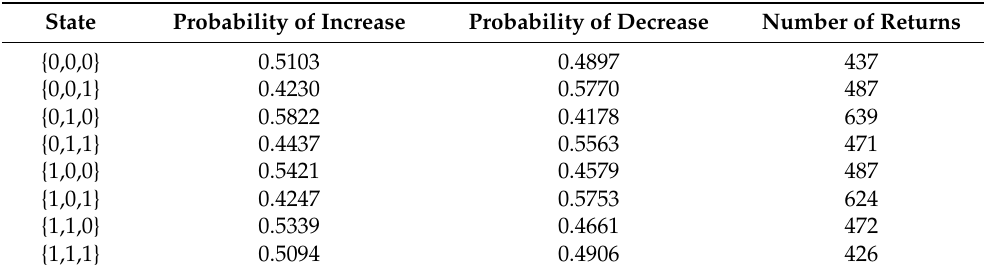
Table 1. Probability estimation for ups and downs of the AUD/NZD instrument in SMBR(25;3) model. Source: author.